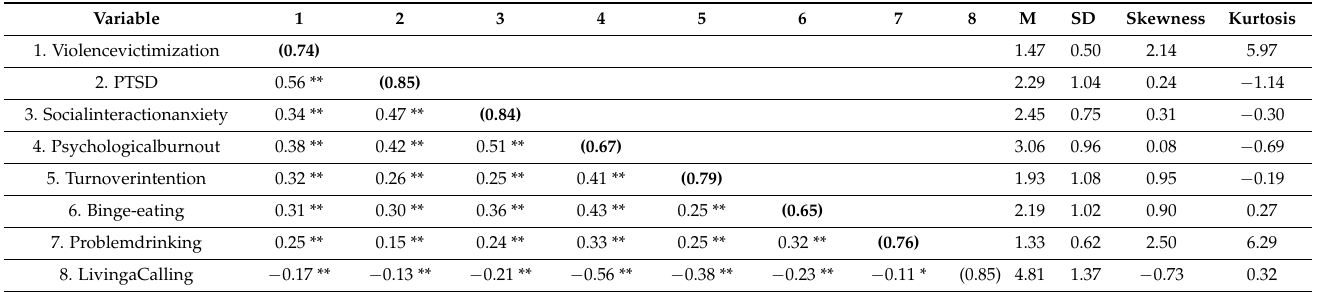
Table 1. Means and standard deviations, correlations, and discriminant validity of the measurement